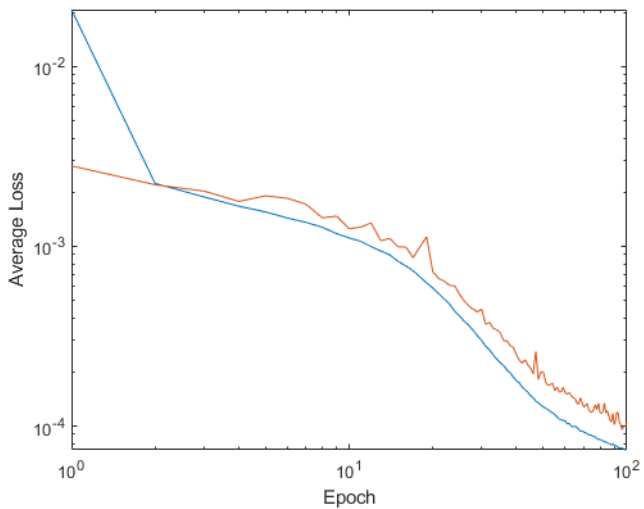
Figure 2. Average loss on training patterns in blue and validation patterns in orange for Dynamic alpha SGD of Mexican Hat.